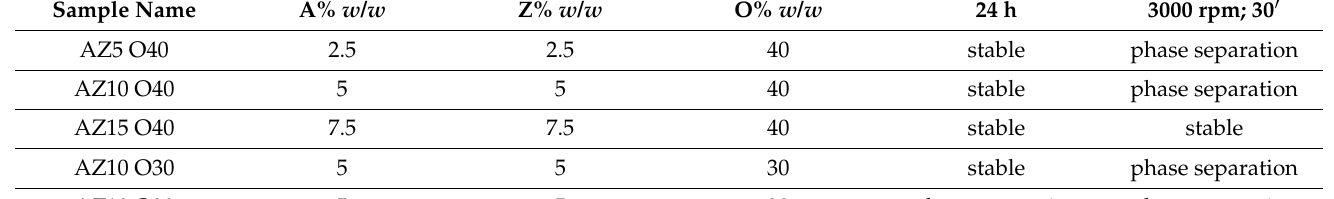
Table 2. Stability test results of systems emulsified with binary associations of Zea mays starch (A) and zinc oxide (Z) (ratio 1:1) varying the percentages of the total solid phase and of the oily phase (O).